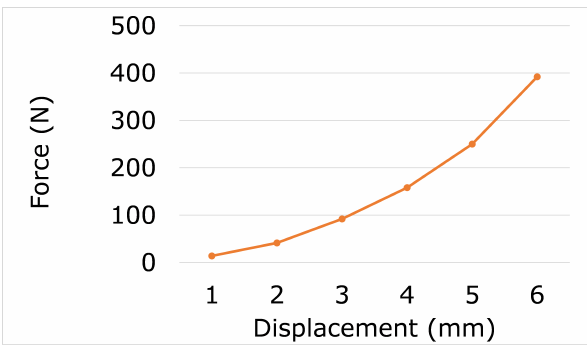
Figure 3: Force displacement graph showing how the Elastomer core TacTip can apply up to 400N at its typical displacement depth of 6mm.